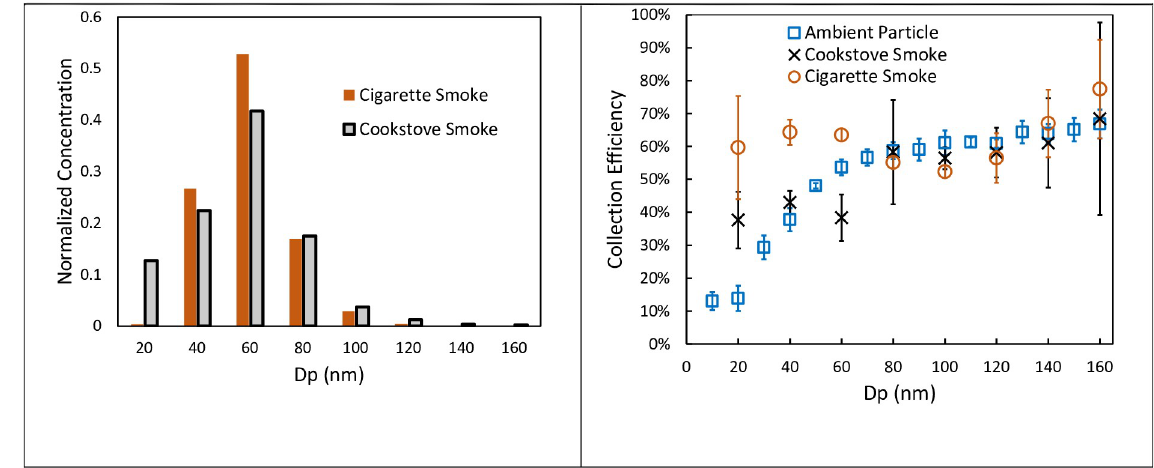
Fig 1. Left—Particle size distribution for Cigarette and Cookstove smokes; Right–Collection efficiency of parallel plate collector for combustion-generated aerosols and ambient particles. Collection efficiency of parallel plate collector for ambient PM as a function of particle size at 0.75 slpm. Each data point corresponds to three or more particle count measurements by a TSI SMPS NanoScan particle counter with error bars representing one standard deviation.